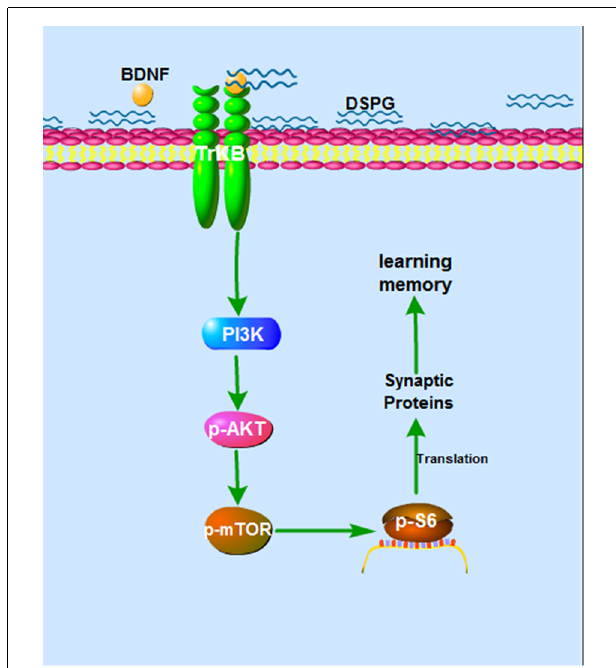
FIGURE 5 | The hypothesized mechanism of DS on learning and memory. Binding of DS to BDNF leads to activation of BDNF activity. The BDNF-TrkB signaling activates Akt pathway, which stimulates mTOR signaling. This can lead, through regulation of p-S6, to increased translation and increased synaptic proteins, which contributes to synaptic